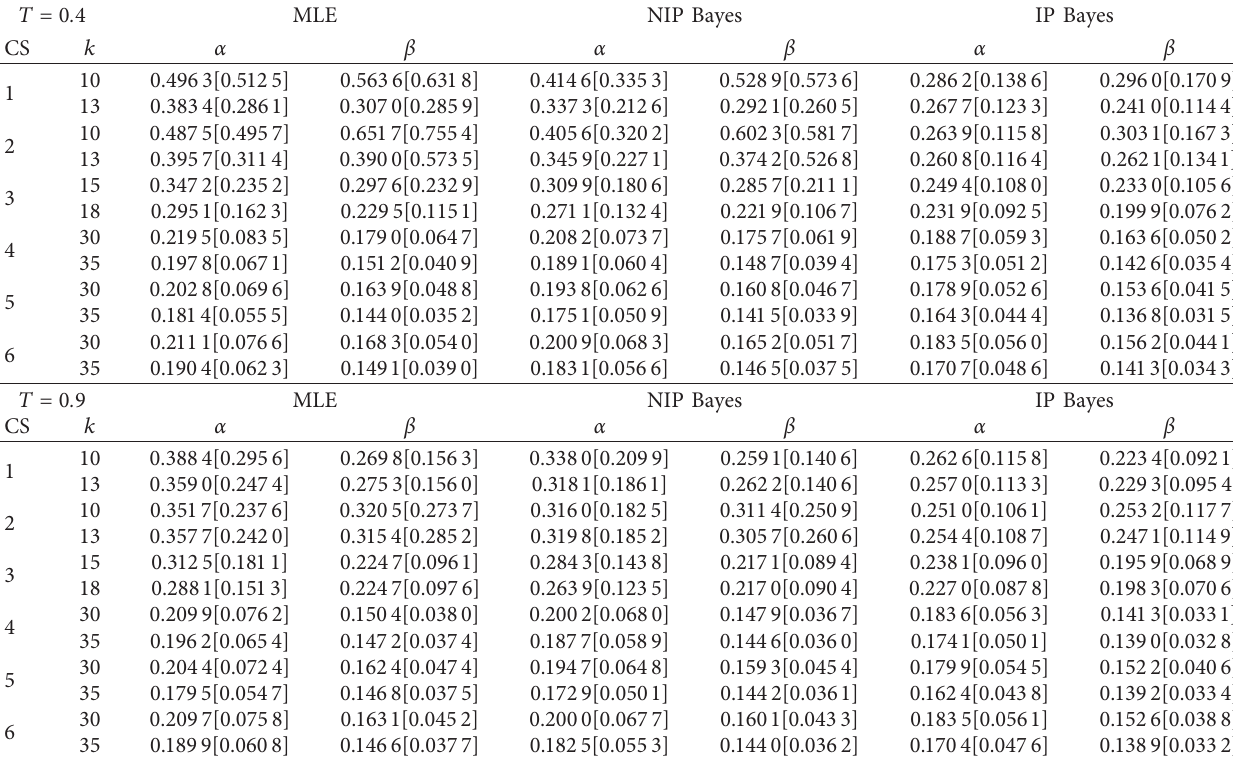
Table 3: ABs and MSEs (within brackets) of the MLEs and Bayes estimates under generalized progressively hybrid censored data with ( α , β ) � ( 1 . 5 , 1 ) .